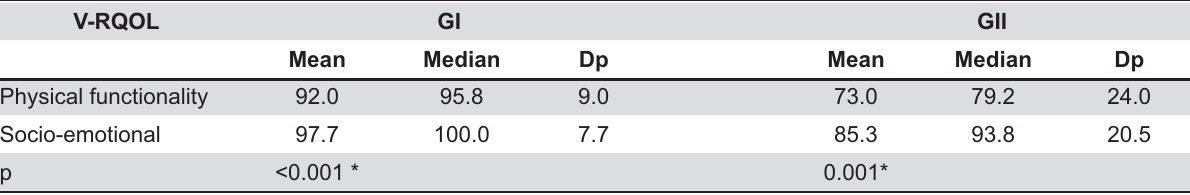
Table 3- Comparison between the domains of Voice-Related Quality of Life (V-RQOL) for groups GI (reported no vocal alteration) and GII (reported vocal alteration)